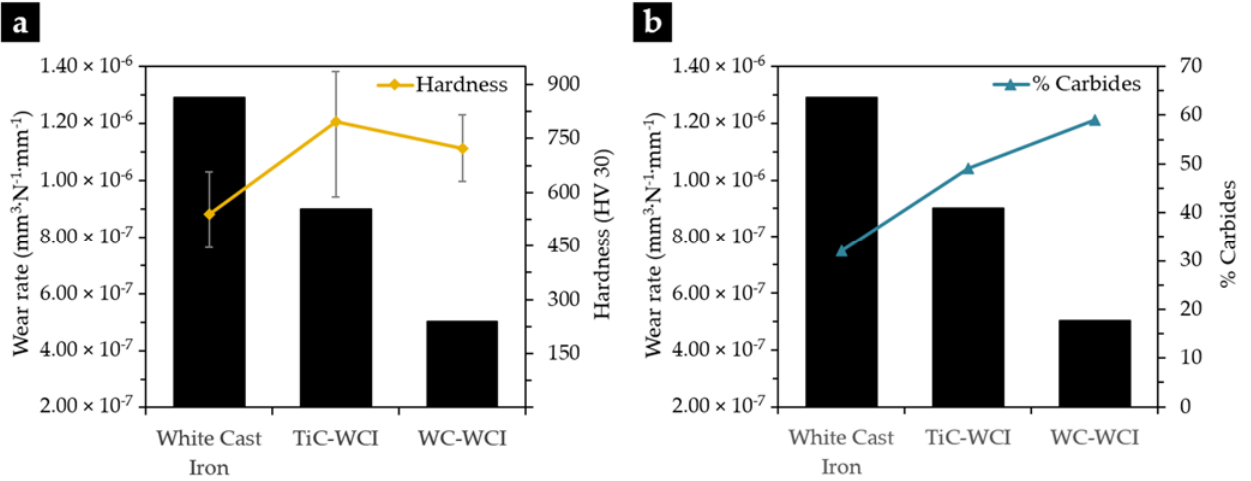
Figure 8. Wear rate results as a function of ( a ) bulk hardness and ( b ) percentage of carbides.